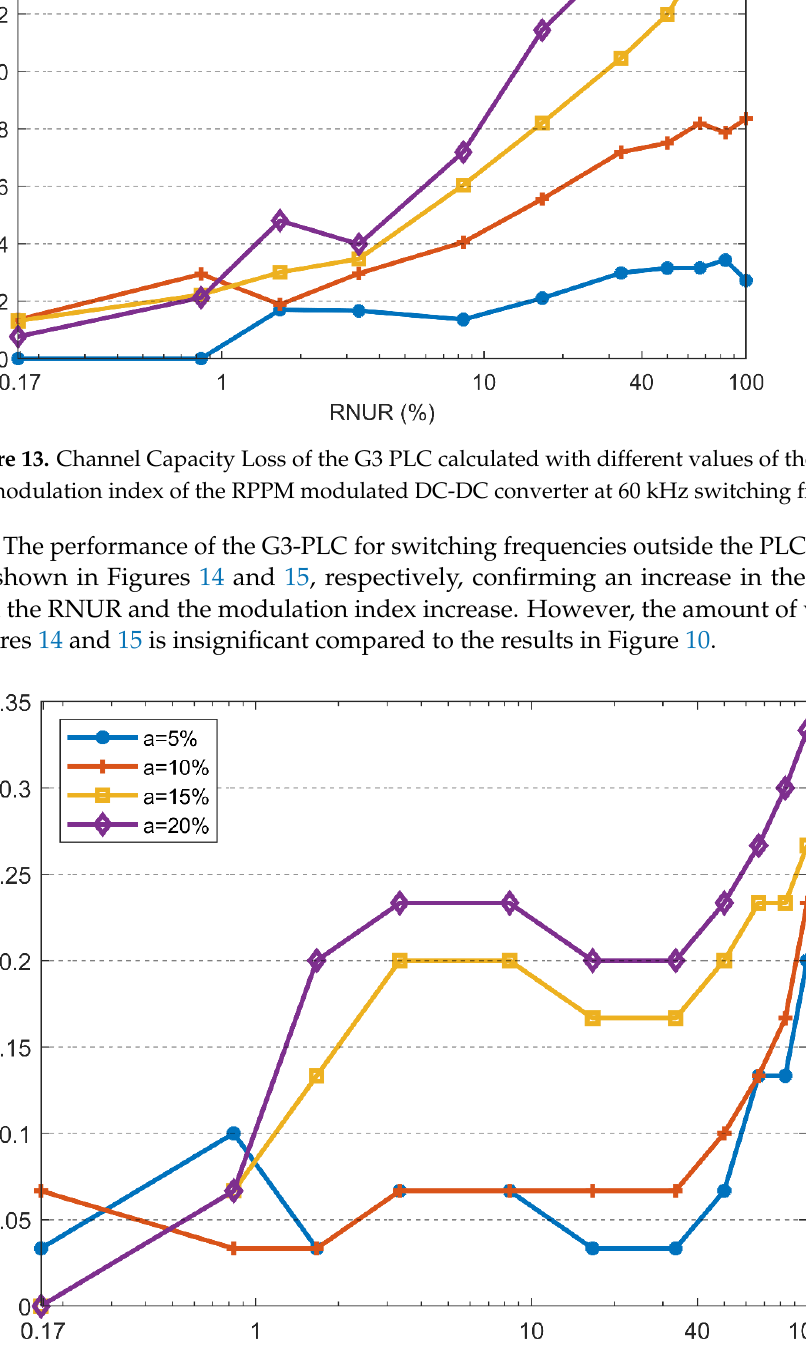
Figure 14. FER of the G3 PLC measured with different values of the RNUR and the modulation index of the RPPM modulated DC ‐ DC converter at 10 kHz switching frequency.